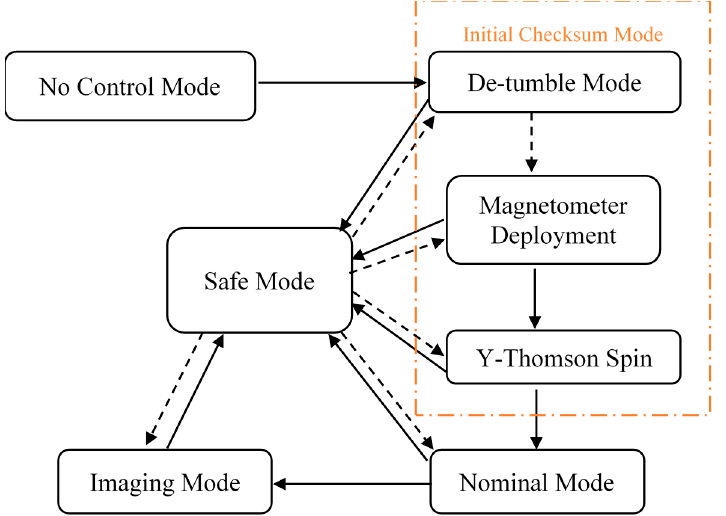
Figure 9. MeznSat ADCS modes of operation.